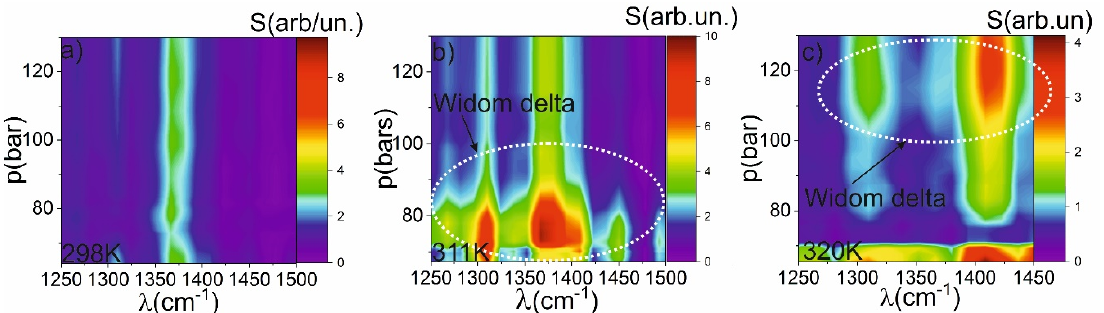
Figure 4. The 3D p-T maps of the Raman scattering intensity at different temperatures: ( a ) 298 K, ( b ) 311 K, ( c ) 320 K.